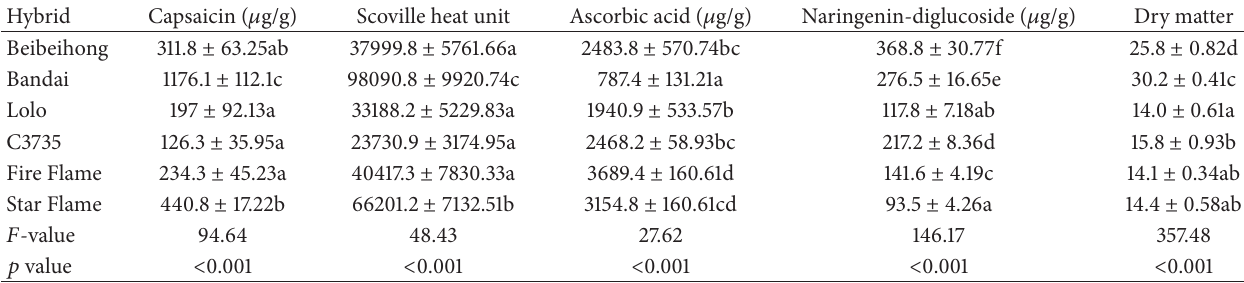
Table 5: Capsaicin, ascorbic acid, and naringenin-diglucoside content ( 𝜇 g/g fresh weight base), pungency unit of Scoville, and dry matter of different chili hybrids. The values represent means ± standard deviation ( 𝑛 = 3